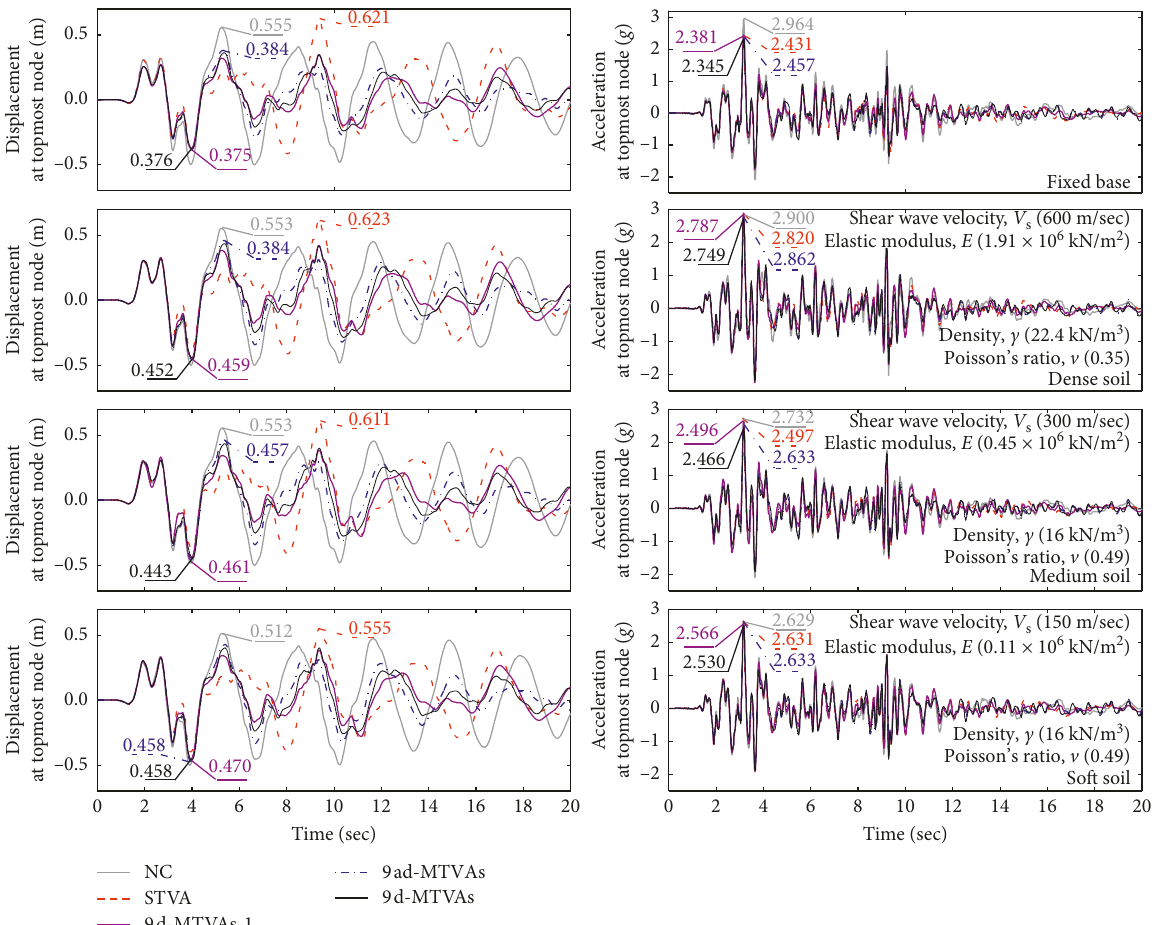
Figure 4: Time variation of displacement and acceleration at the topmost node of the chimney under Nahanni (1985); TVAs are with the mass ratio ( µ ) of 2% and damping ratio ( ζ d ) of